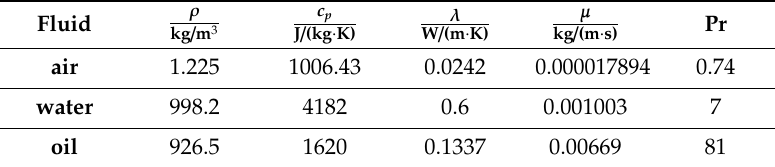
Table 1. Thermal physical parameters of working fluid.